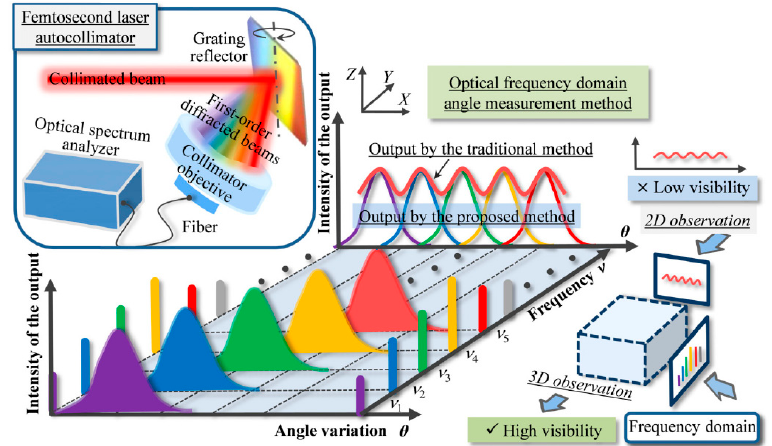
Figure 6. Mode-locked femtosecond laser autocollimator based on the optical frequency-domain angle measurement [56].